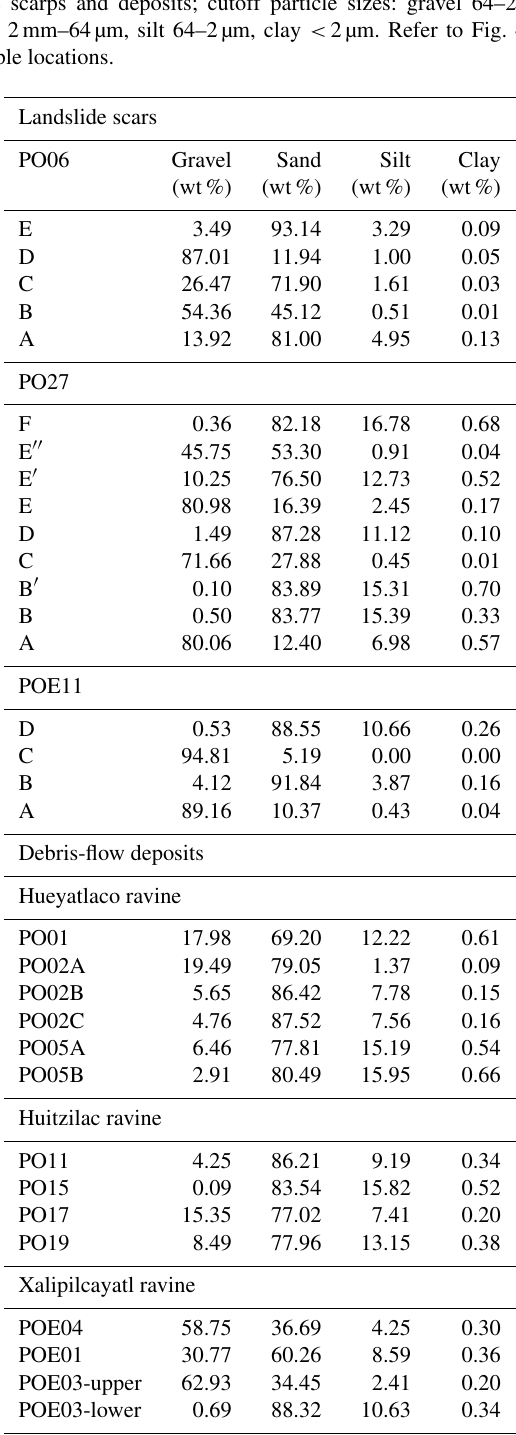
Table A1. Grain size distributions of samples collected in the land- slide scarps and deposits; cutoff particle sizes: gravel